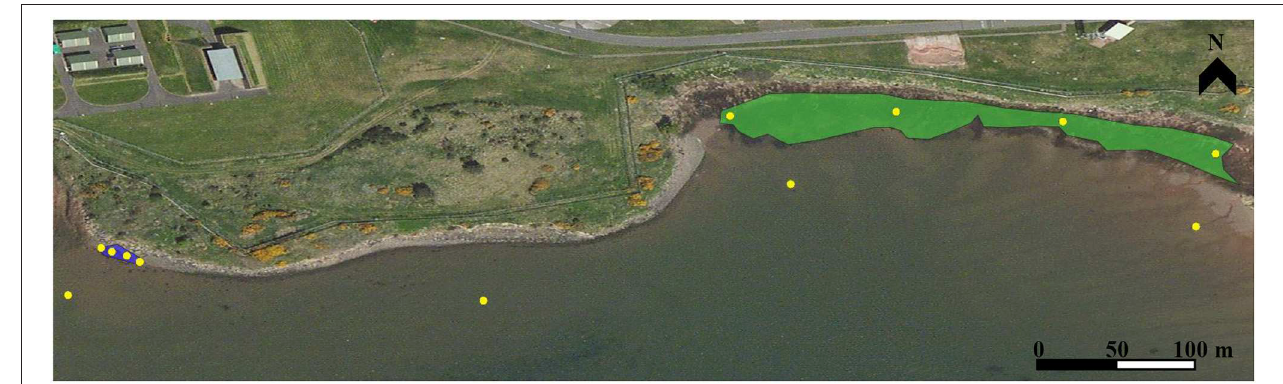
FIGURE 1 | The north shore of the Eden Estuary, Scotland. The green polygon delineates the full extent of the “Natural” saltmarsh, an area of 450 m 2 , made up of a robust bed of B. maritimus . The blue polygon delineates the extent of the “Restored” area, a total of 100 m 2 , consisting of a planted mono-specific stand of B. maritimus . The “Mudflat” area consisted of the entire adjacent fringing edge running along the coast between the extreme ends of the natural and restored vegetated areas. The yellow points are the location of permanent sampling